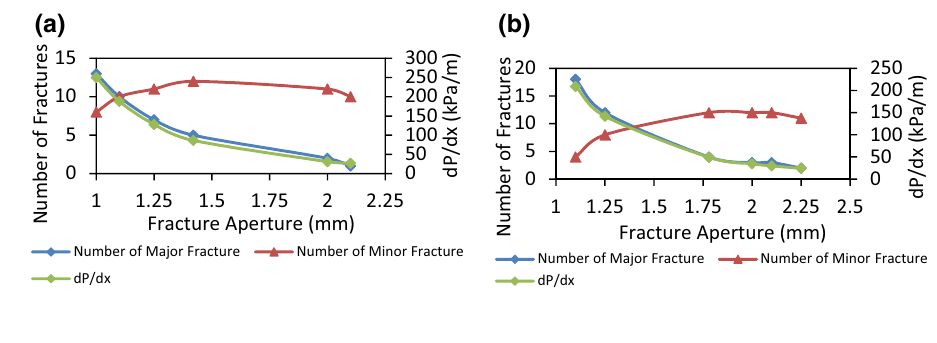
Table 3 Young’s modulus and SRV effect on the major and minor fractures